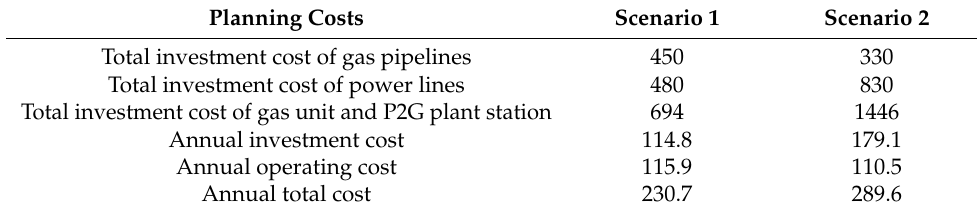
Table 2. Comparisons of planning costs (units: million